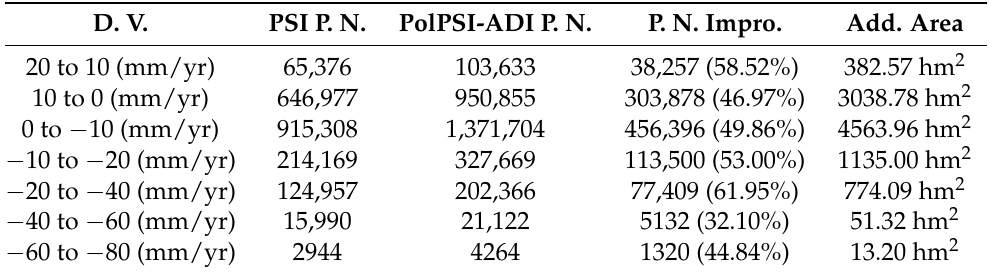
Table 2. Statistical analysis of the PSI and PolPSI-ADI retrieved ground deformation results over